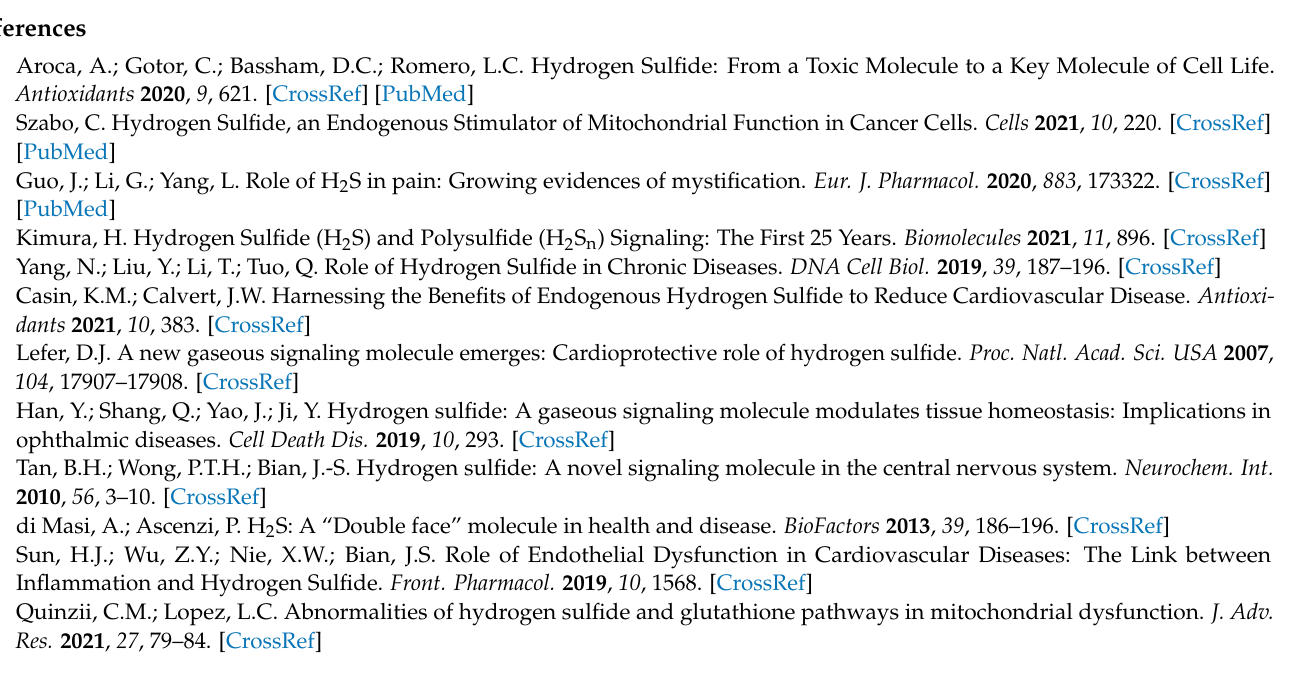
Figure S3: ESI-HRMS spectrum of 1 . Figure S4: ESI-HRMS spectrum of the mixture of 1 and H 2